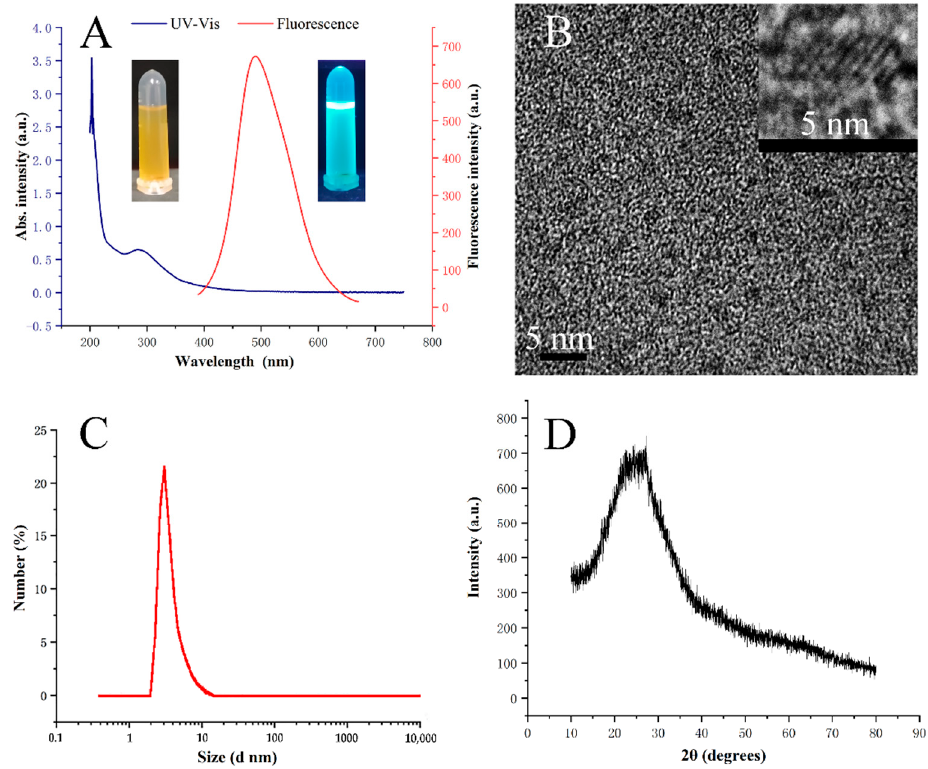
Figure 1. ( A ) UV-Vis spectra and fluorescence spectra of Ce-CDs-FA (inset: photographs of 1 mg/mL Ce-CDs-FA solution under natural light and 365 nm UV lamp). ( B ) TEM photograph (inset: HRTEM image). ( C ) DLS measurement. ( D ) XRD analysis.